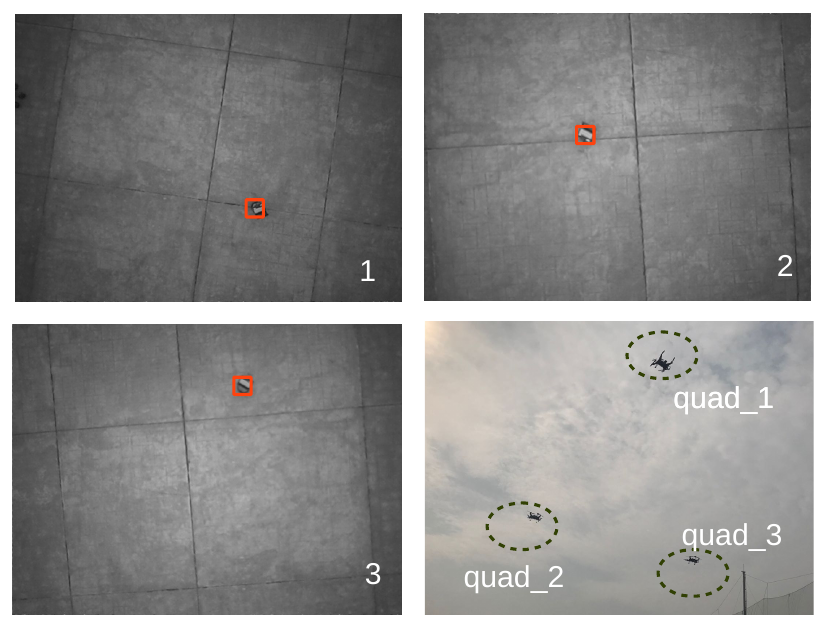
Figure 10. Snapshot of the CLAT experiment setup (three quadrotors and corresponding captured image).